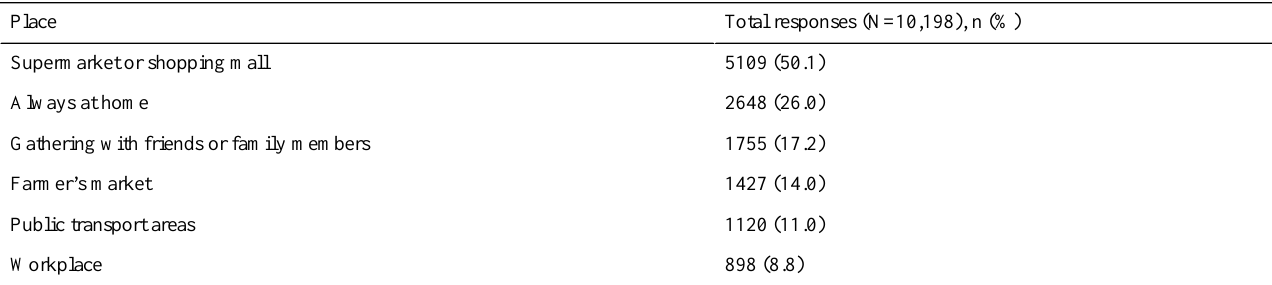
Table 4. Places that participants had been to during the coronavirus disease (COVID-19) epidemic period prior to taking the survey.